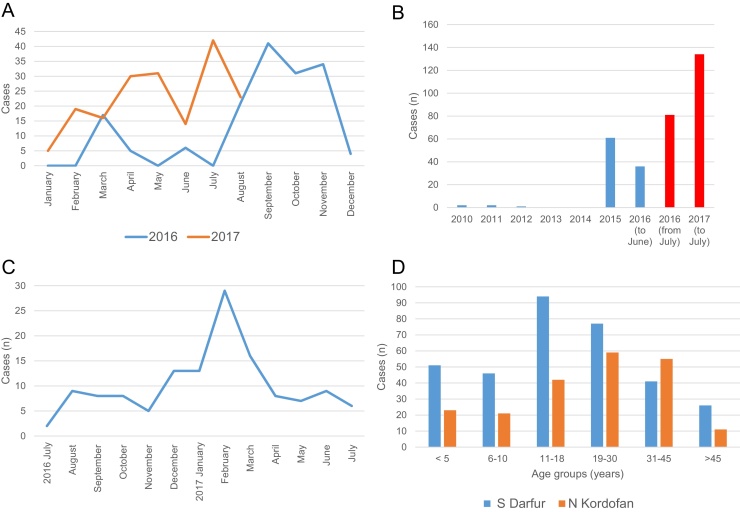
Southern Darfur and Northern Kordofan Ministry of Health data. (A) Southern Darfur Ministry of Health cutaneous leishmaniasis case reports showing differing profiles in 2016 (blue line) and 2017 (orange line). (B) Northern Kordofan cutaneous leishmaniasis cases reports by the Ministry of Health – Health Information System between 2010 and June 2016 (blue bars), and by hospital line listing from July 2016 to July 2017 (red bars), showing a sharp increase from 2015. (C) Northern Kordofan State cutaneous leishmaniasis case reports between July 2016 and July 2017, for which the month was reported, showing a peak in winter (February); 46 cases were excluded as the month was not reported. (D) Age distribution of cases, Southern Darfur (blue bars) and Northern Kordofan (orange bars).